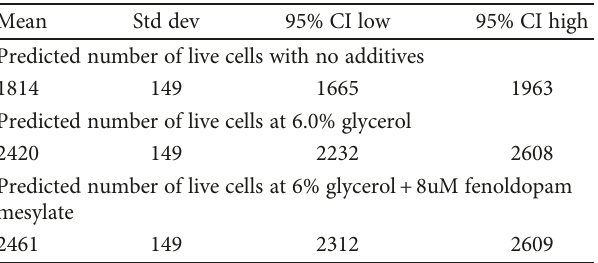
Table 5: Estimated number of live cells by the Design-Expert Point Prediction tool.